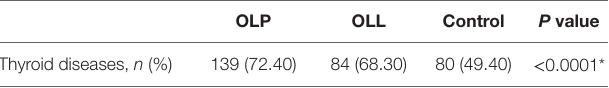
TaBle 3 | Prevalence of thyroid diseases in oral lichen planus (OLP), oral lichenoid lesion (OLL), and control group.